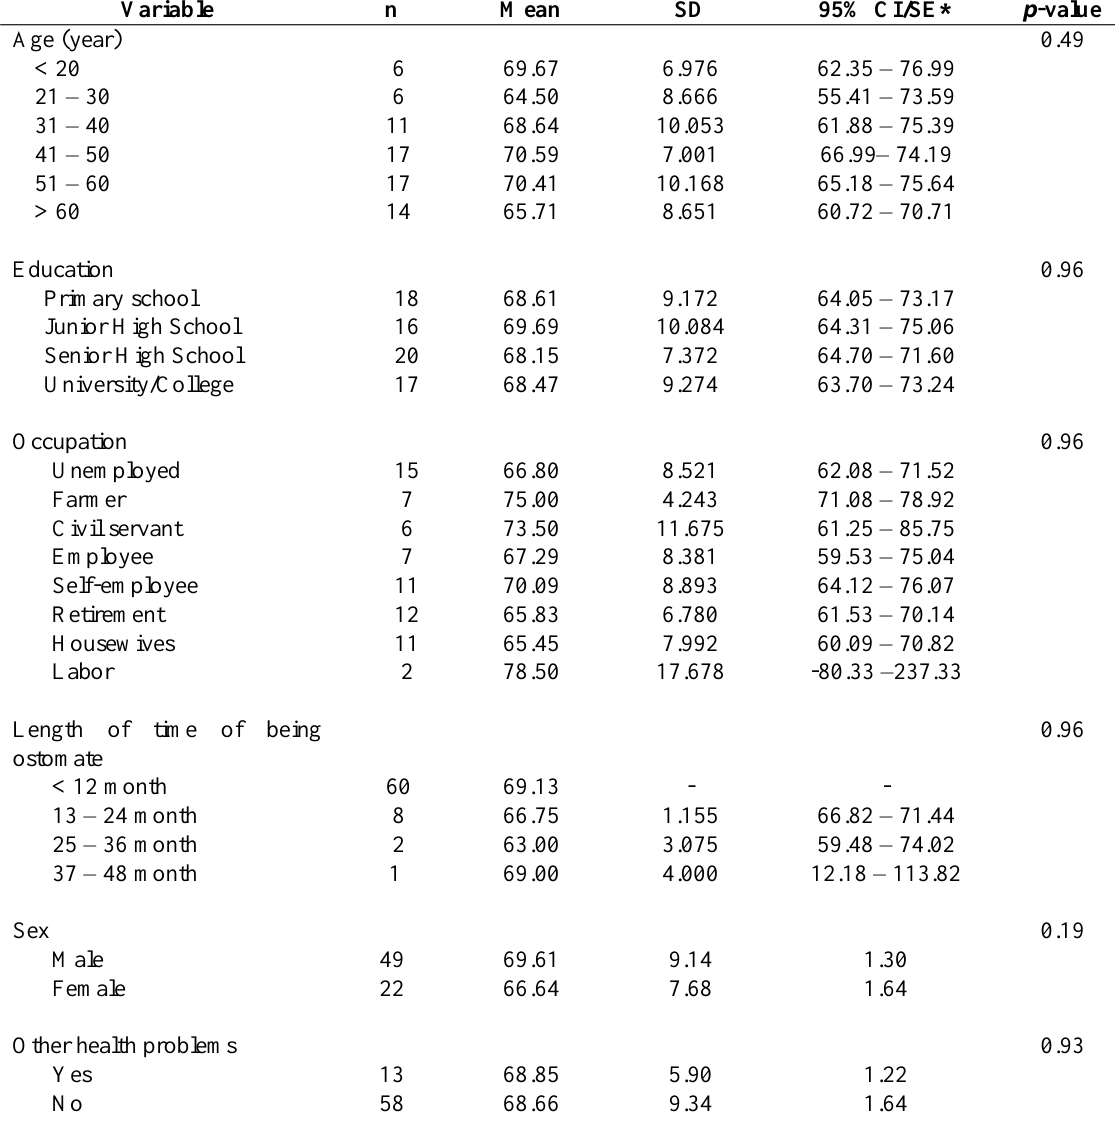
Table 7. The differences of total mean score of quality of life-based on age group, education, occupation, length of time of being ostomate, sex, and other health problems